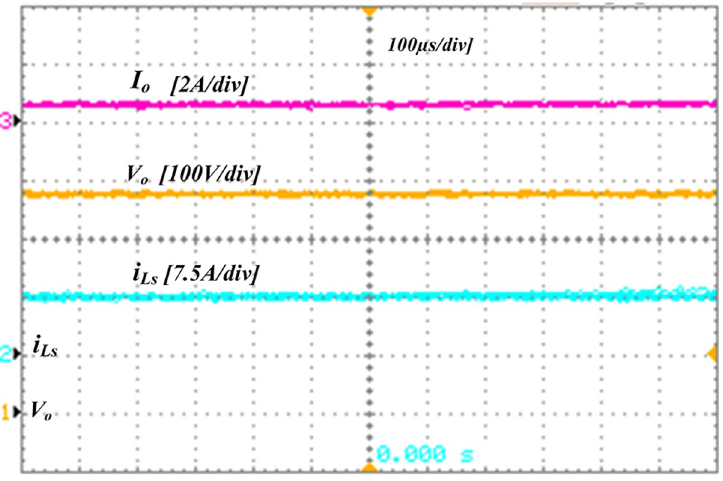
Fig 11. Experimental results. The output voltage, V o , boost inductor current, i Ls and output current, I o .